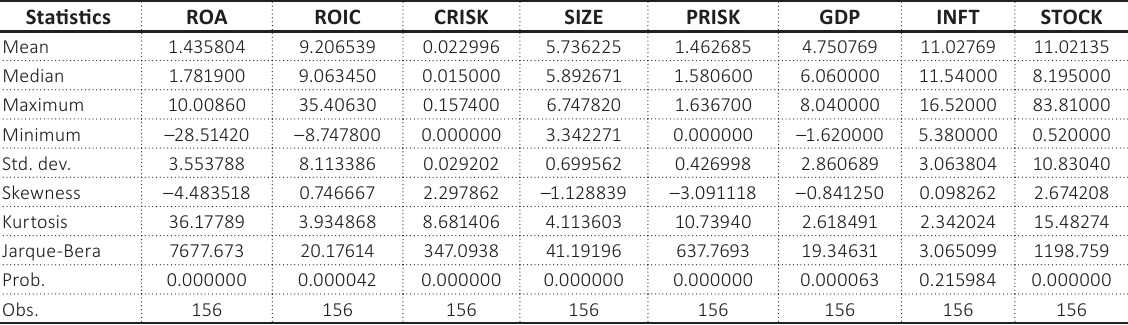
Table 1. Descriptive statistics results